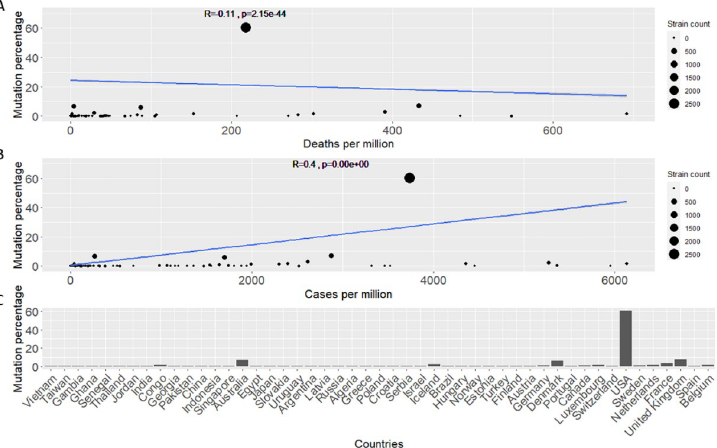
correlation is shown by the R value accompanied by the p -value of the correlation coefficient. B. Similar regression fit for mutations percentage across countries this time showing cases per million for each country. C. Detailed histogram of the percentage occurrence of the mutation across different countries. Countries are sorted with increasing deaths per